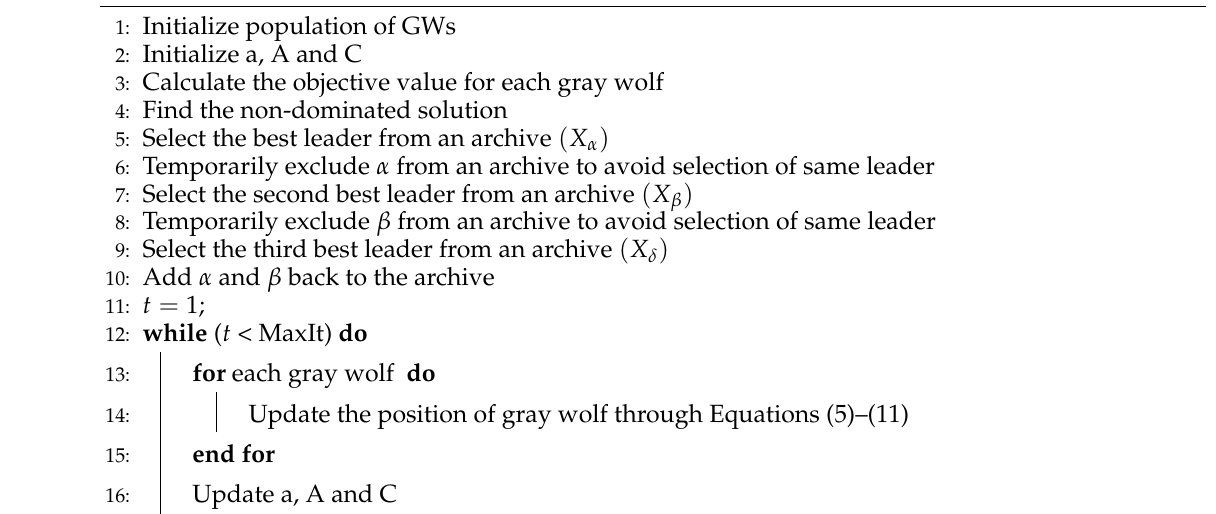
Algorithm 1 Pseudocode of the MOGWO